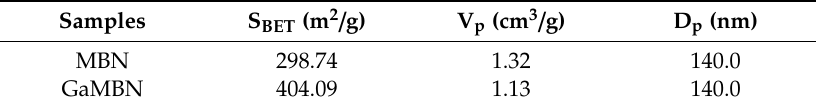
Figure 4. N 2 adsorption–desorption isotherms and pore size distribution of MBN and GaMBN. Table 2. N 2 adsorption–desorption results .